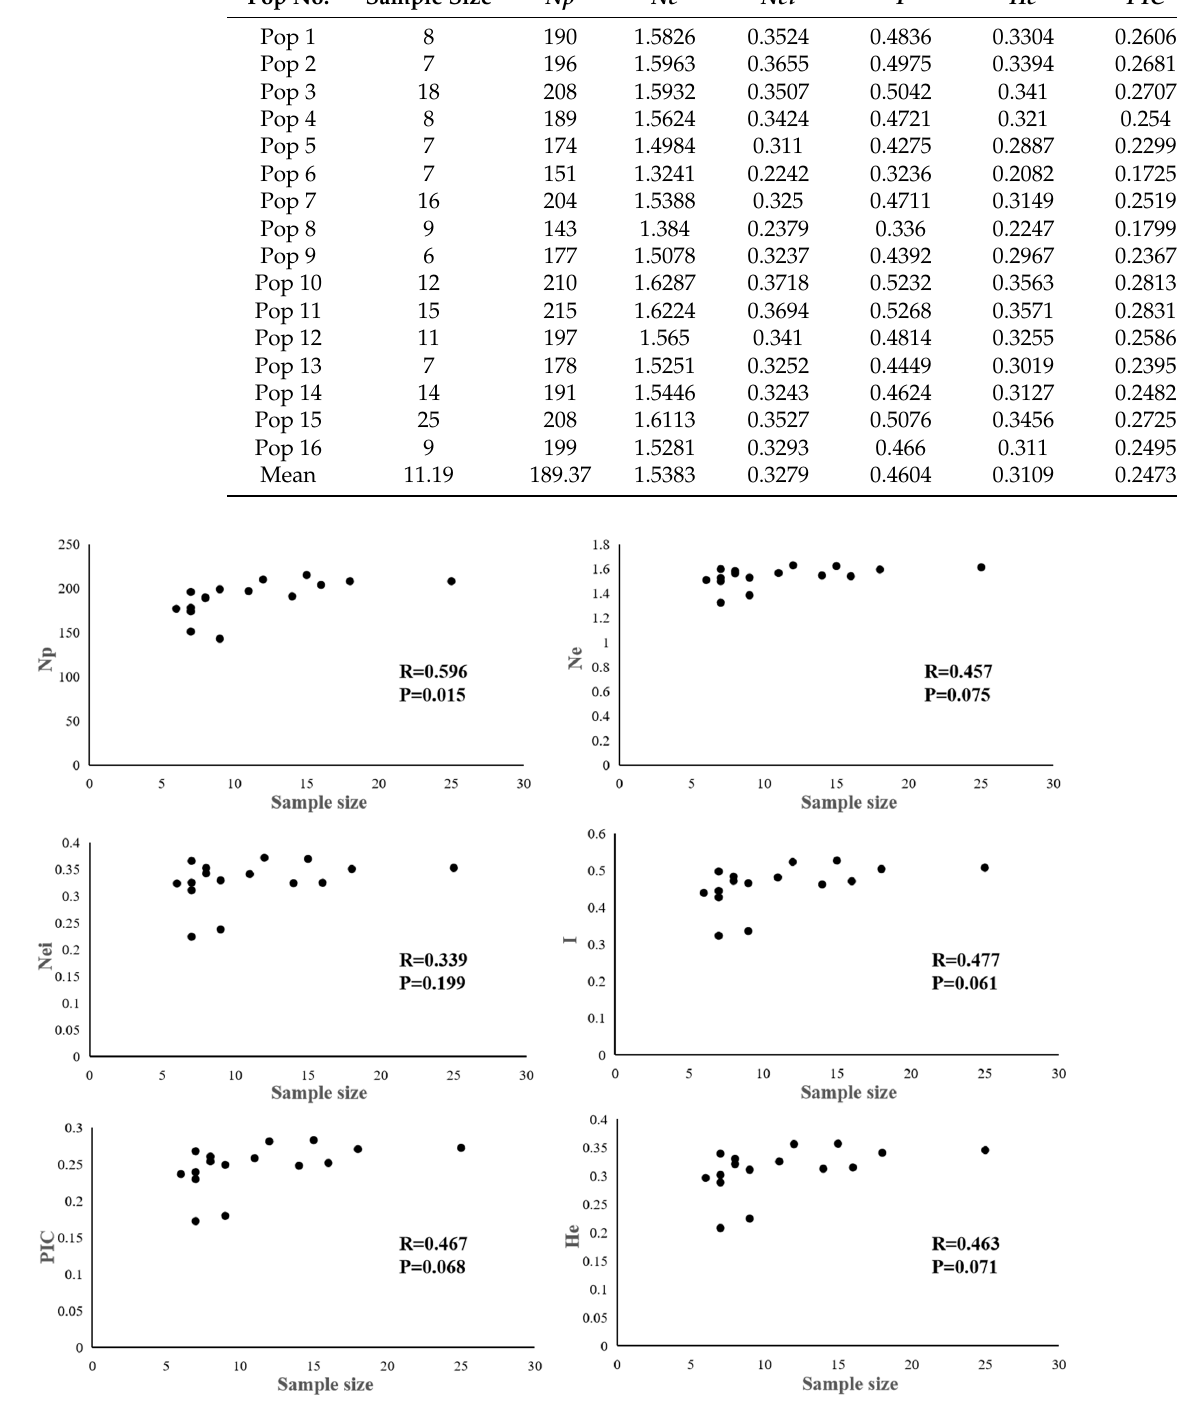
Figure 3. The correlation coefficient between population genetic diversity parameters and the sample size of germplasm populations.